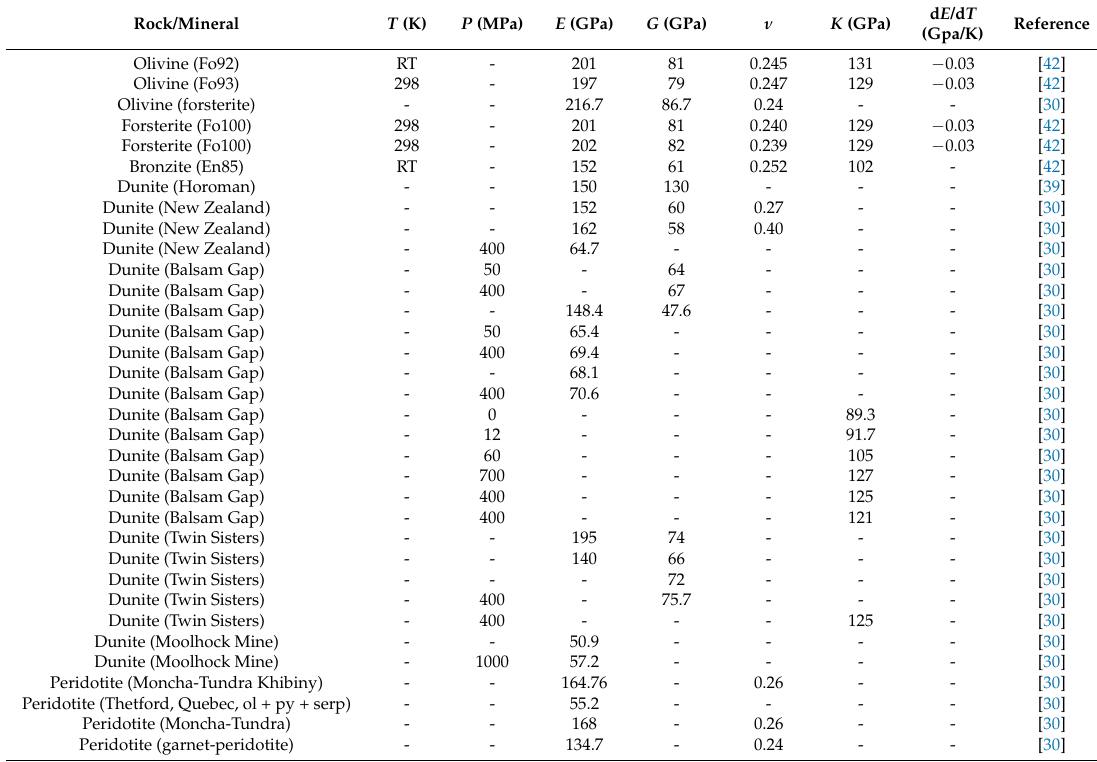
Table 4. Literature values for elastic constants for the principal peridotite minerals, and for various ultramafic and mafic rocks. T and P indicate measurement conditions (RT is room temperature). E , G , ν , and K are Young’s modulus, Shear modulus, poisson’s ratio, and Bulk modulus, respectively. The temperature derivative of Young’s modulus (d E /d T ) is also